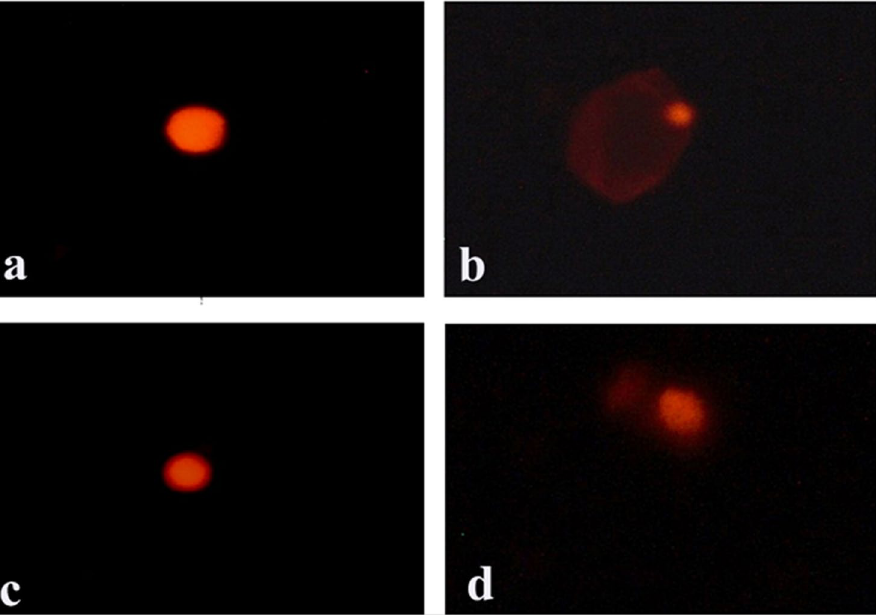
Figure 1. Comet assay in hepatic tissue of different groups. ( a ) Group 1 (control) showing circular intact DNA; ( b ) Group 2 (irradiated animals) showed comet shape and tailed DNA; ( c ) Group 3 (Date syrup) showing circular intact DNA similar to control group; ( d ) Group 4 (Irradiation + Date syrup) showing moderately intact circular DNA.